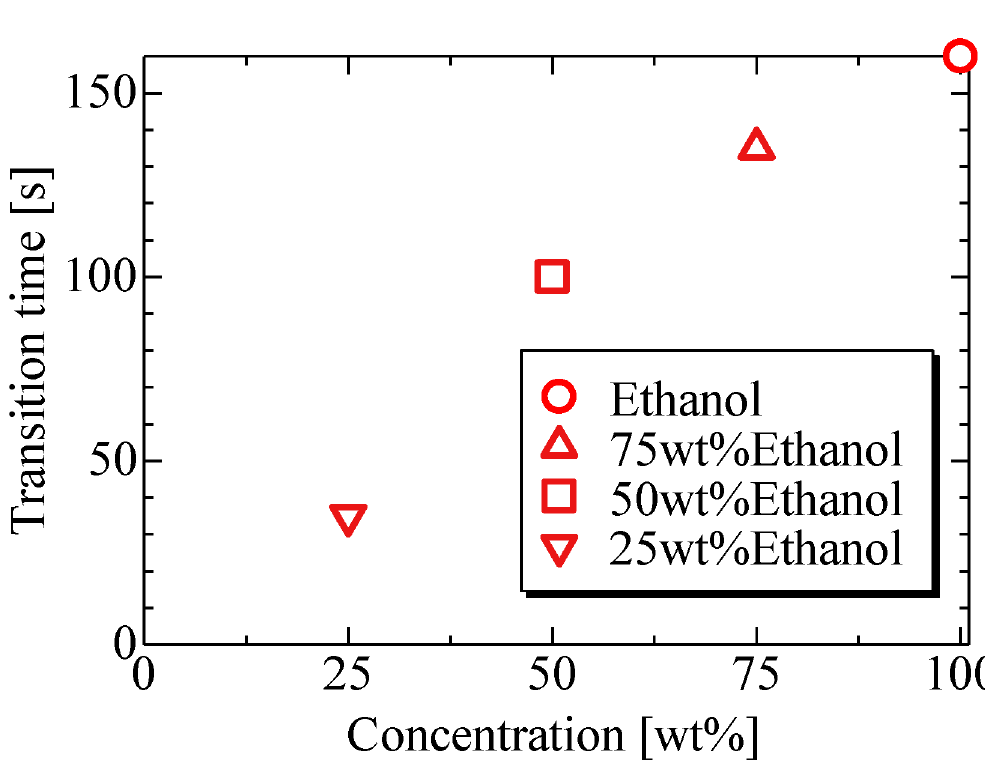
Fig 8. Transition time of ethanol solution